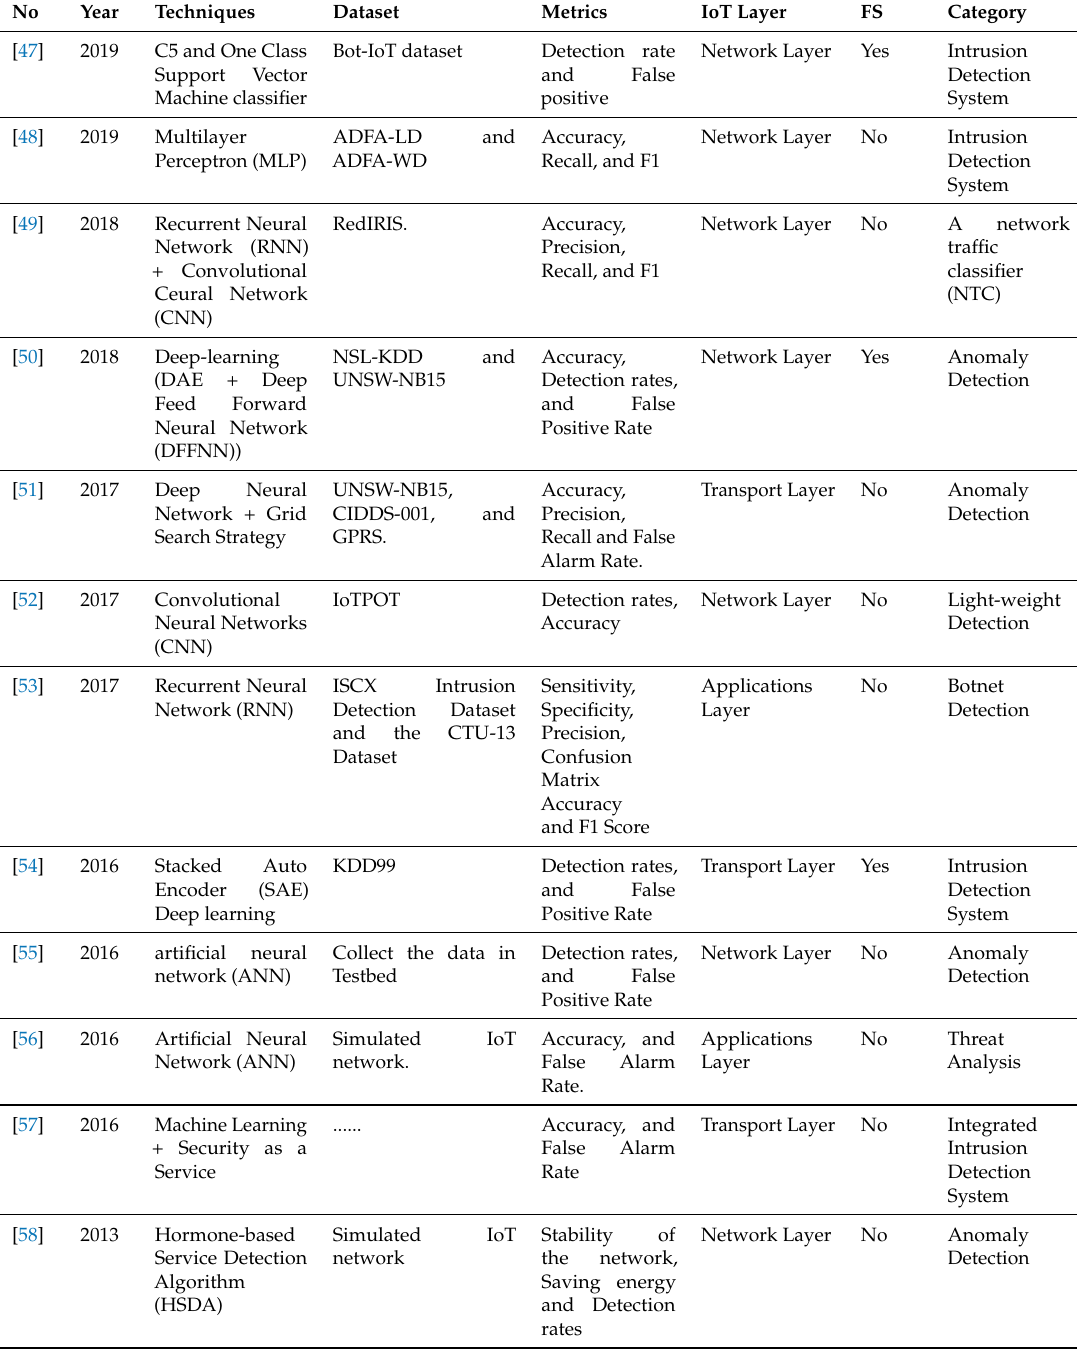
Table 2. Artificial Intelligence-based Security Methods (FS = Features